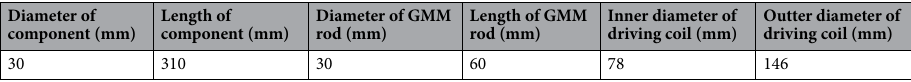
Length of component (mm)